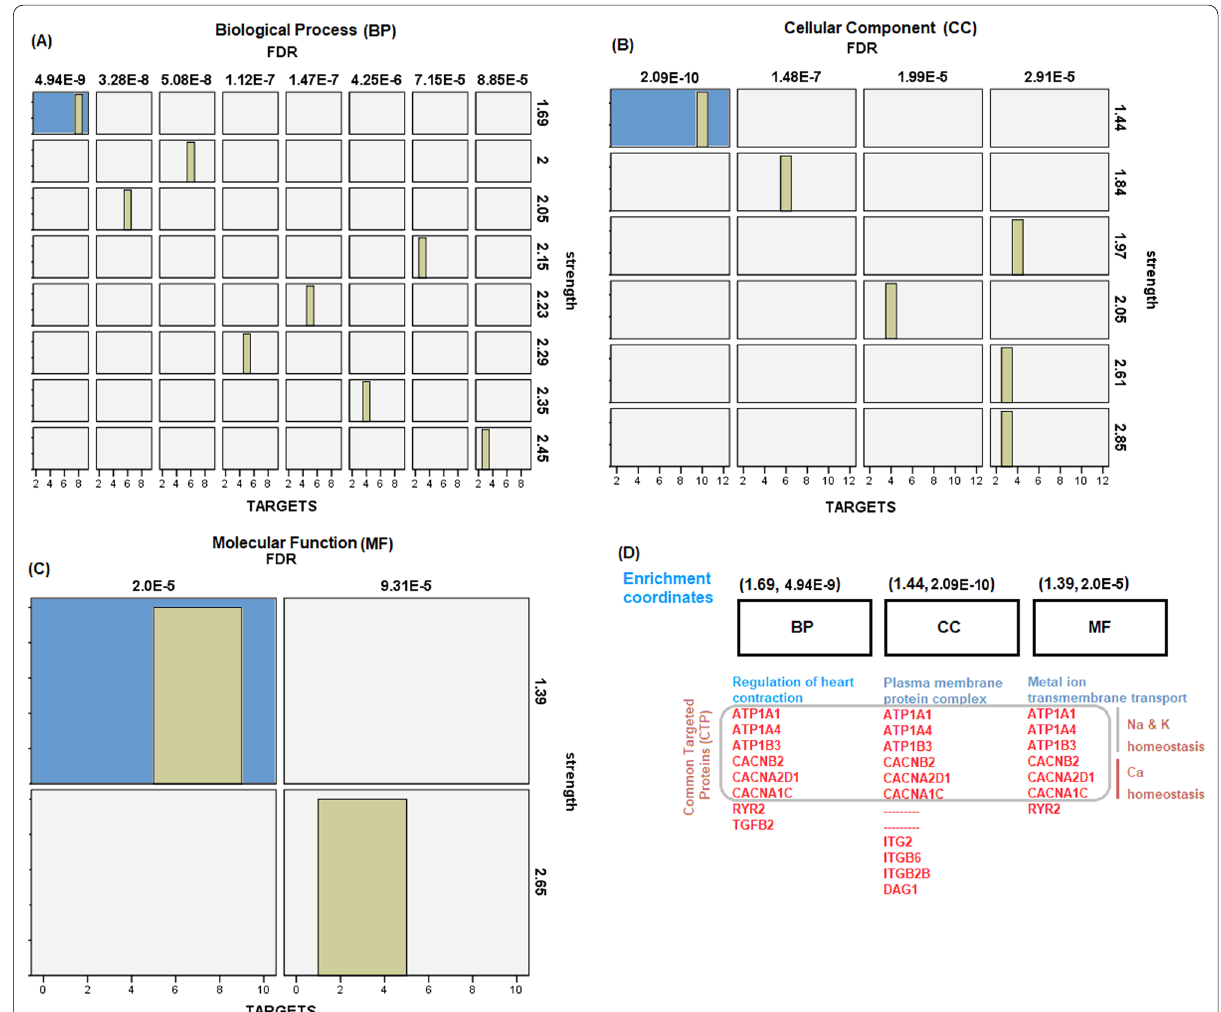
Fig. 4 Differential PPI enrichment network according to the biological process ( A ), cellular components B and molecular function ( D ). The blue square highlighted refer to the best coordinate containing lowest FDR, highest number of protein as targets and followed by strength. C Represents intersected enrichment coordinates showing highly potential role of calcium (Ca), sodium (Na) and potassium (K) ions homeostasis cross the cardiac sarcolemma in CDCM